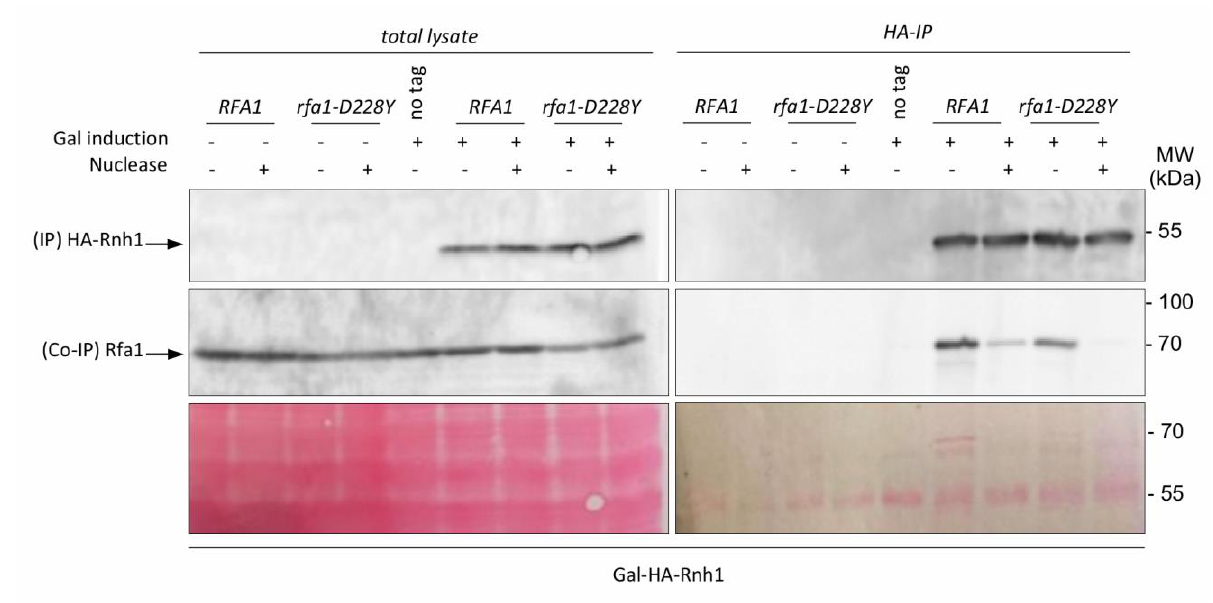
FIGURE 6: Rnh1 interacts with RPA . Co-immunoprecipitation experiments were performed in triplicate. HA-Rnh1 has been overexpressed by galactose addition and immunoprecipitated with an anti-HA antibody. The presence of RPA in the HA-Rnh1 IP is monitored with an anti-Rfa1 antibody. Cell extracts treated with nuclease (Thermofisher) are indicated (+). Yeast strains were grown in medium containing 2% glucose (-) or 2% galactose (+) when mentioned. Total proteins on the membrane were stained with Ponceau S as a loading control (Bottom). MW: mo- lecular